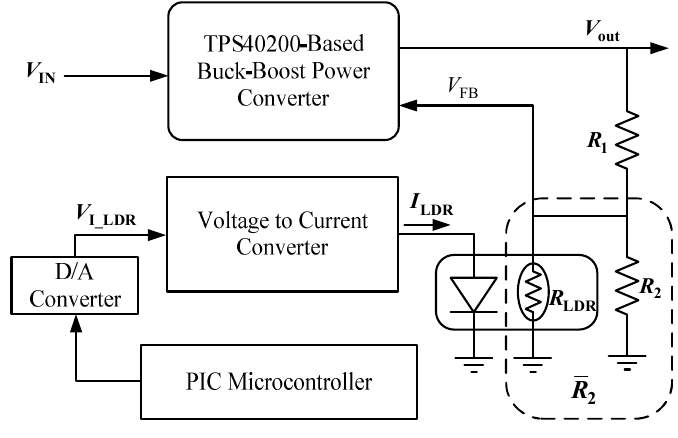
Figure 9. Open loop system for LDR control.